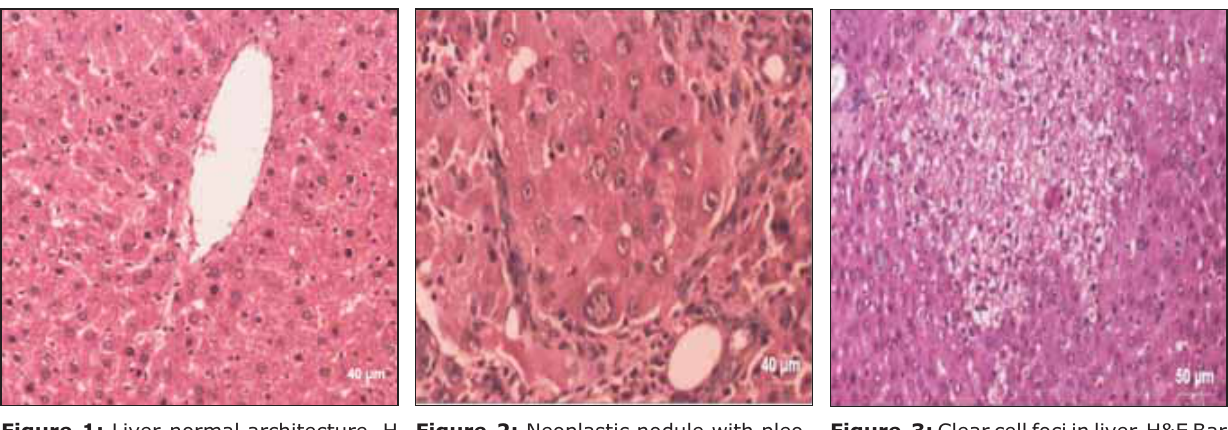
Figure-3: Clear cell foci in liver, H&E Bar =